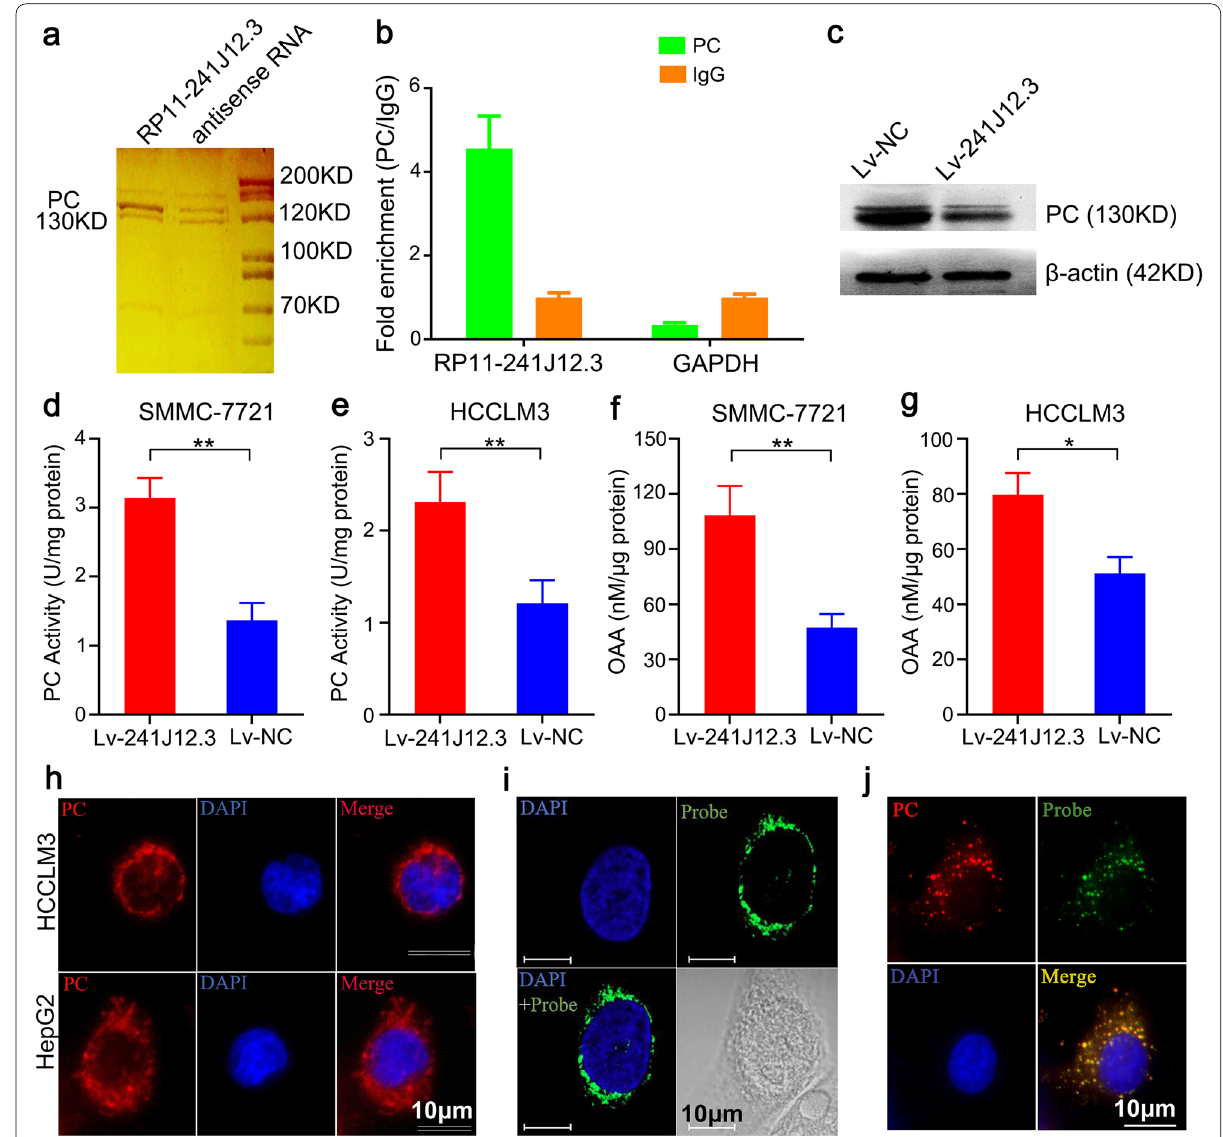
Fig. 5 LncRNA RP11-241J12.3 bound directly to PC in the cytoplasm to regulate pyruvate metabolism. a RNA pull-down assays with HepG2 cytoplasm extract with specific bands identified by MS. b qPCR analysis of the RNAs retrieved by the PC-specific antibody compared with IgG in the RIP assay of HepG2. c The protein expression levels of PC were upregulated after RP11-241J12.3 overexpression in HepG2 and SMMC-7721 cells. d‑e The PC activities were upregulated after RP11-241J12.3 overexpression in SMMC-7721 and HCCLM3 cells. f‑g The levels of OAA in RP11-241J12.3 overexpressing HCC cells were obviously higher than those of control HCC cells. Data represent the mean SD of at least three replicate ± experiments. h Specific location of PC in the cytoplasm of HepG2 and HCCLM3 cells. i Location of RP11-241J12.3 in the cytoplasm close to the nucleus in HCCLM3 cells. j Colocalization analysis: lncRNA RP11-241J12.3 FISH assay combined with PC immunofluorescence